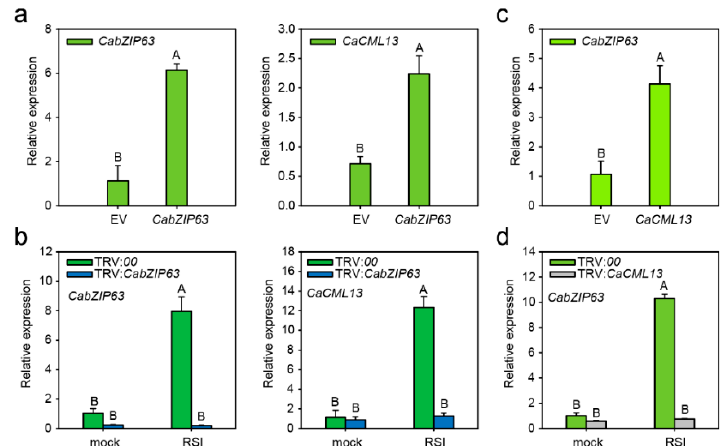
Figure 7. CabZIP63 and CaCML13 positively regulate each other at transcriptional level. ( a ) The relative transcript levels of CabZIP63 and CaCML13 were detected by qRT-PCR in pepper leaves upon CabZIP63 transient overexpression at 24 hpi; ( b ) The relative transcript levels of CabZIP63 and CaCML13 were detected by qRT-PCR in the control and CabZIP63 -silenced pepper plant leaves inoculated with R. solanacearum at 24 h post-inoculation; ( c ) The relative transcript levels of CabZIP63 were detected by qRT-PCR upon transient overexpression of CaCML13 in pepper leaves at 24 hpi; ( d ) The relative transcript levels of CabZIP63 were detected by qRT-PCR in the control and leaves of CaCML13 -silenced pepper plants inoculated with R. solanacearum at 24 h post-inoculation. Data presented are means ± standard error of four replicates. Di ff erent uppercase letters above the bars indicate significant di ff erences among means ( p < 0.01) by Fisher’s protected LSD